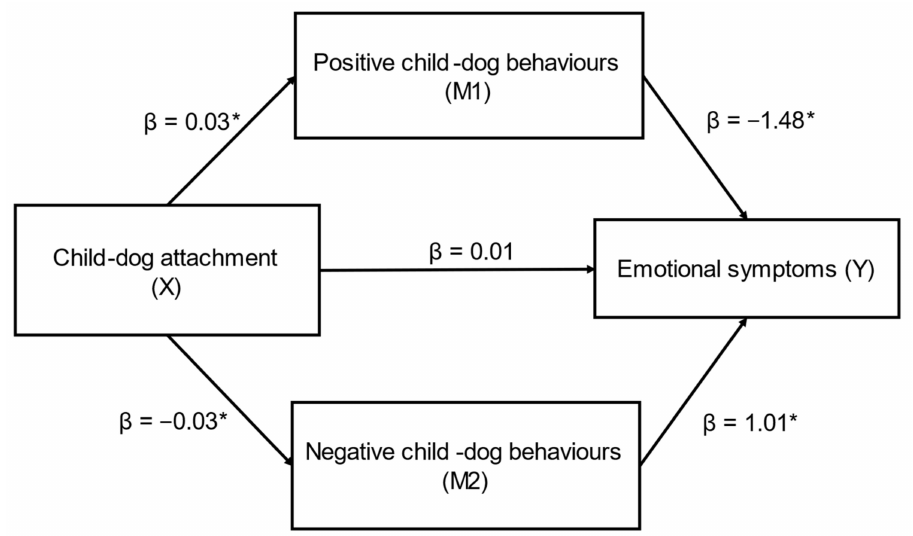
Figure 1. Positive and negative child–dog behaviours as mediators in the relationship between child–dog attachment and emotional symptoms ( n = 83) (ab cs = − 0.33, large effect). Note: * = significant pathway. Child–dog attachment (X) had a significant indirect effect on caregiver-reported con- duct problems (SDQ) (Y) through caregiver-reported positive (M1) and negative